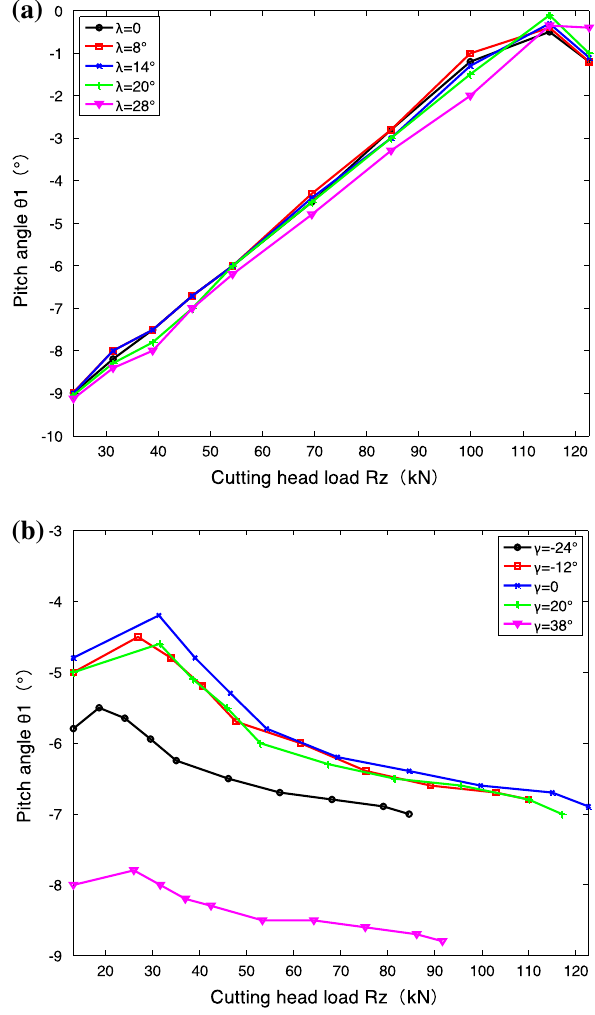
Fig. 18 Experimental results of the pitch angle. ( a ) During horizon- tal cutting process; ( b ) During vertical cutting